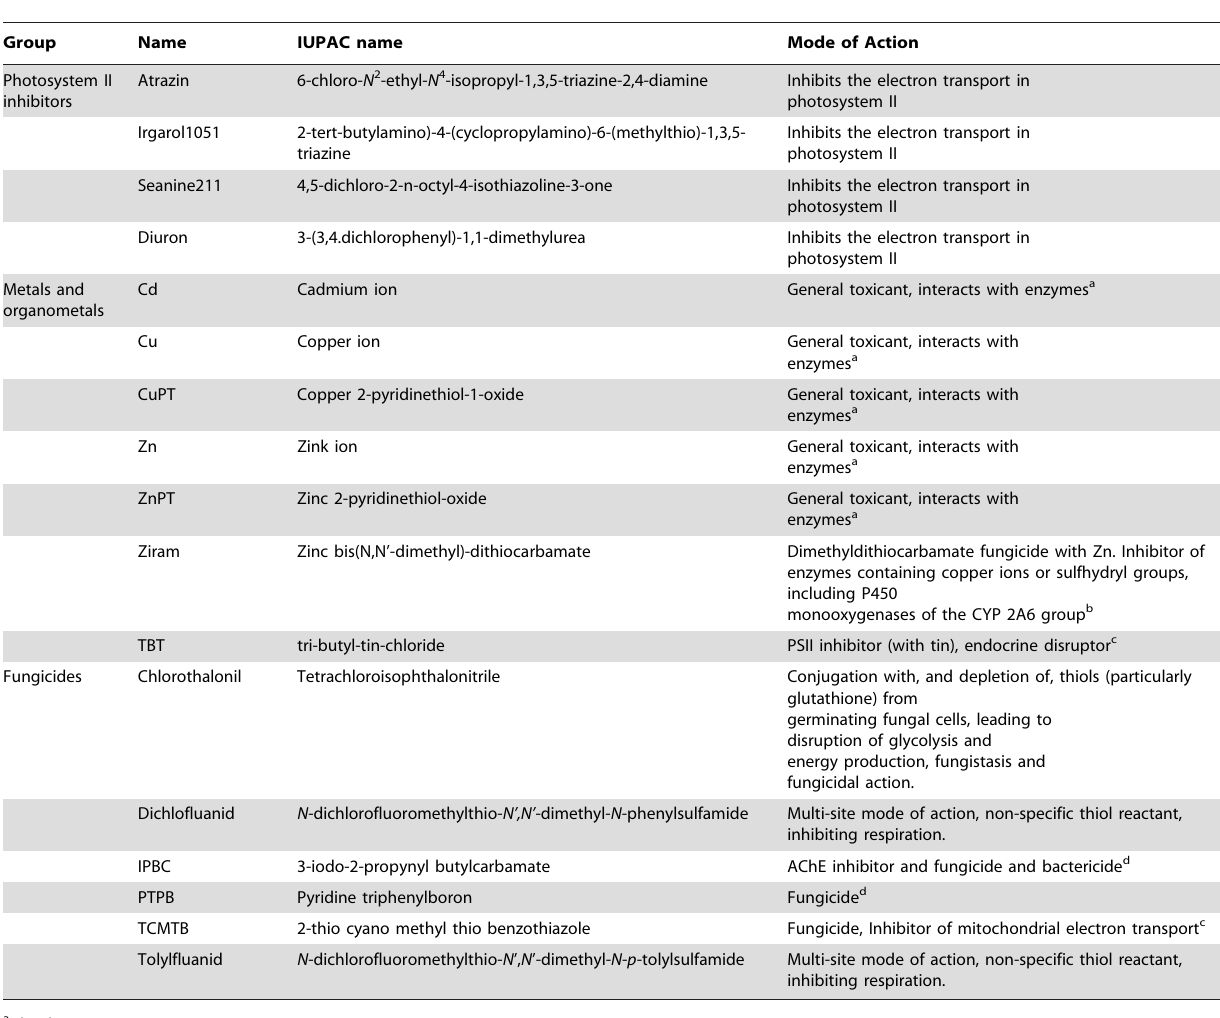
Table 1. The overall group, name and proposed Modes of Action (MoA) of the antifouling compounds.